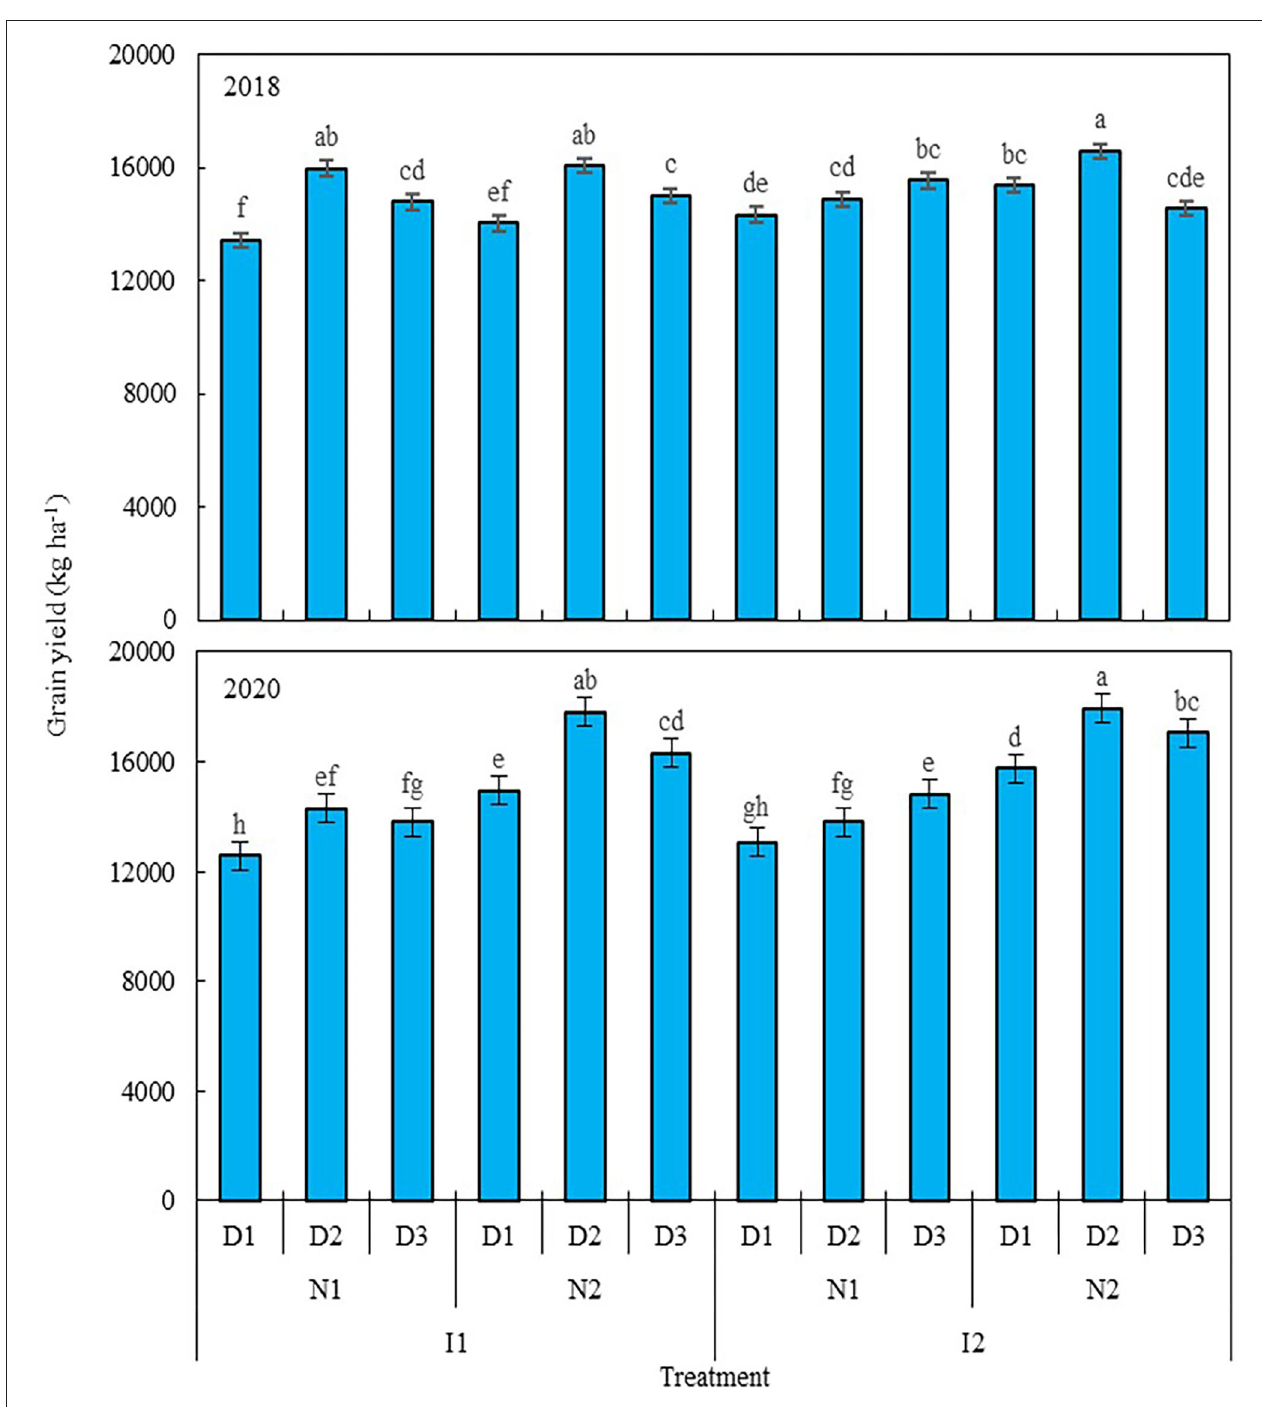
FIGURE 2 | Grain yield of maize as affected by the levels of water, nitrogen, and density in 2018 and 2020. Error bars are standard errors of the means. Different lowercase letters above bars indicate significant differences at the P < 0.05 probability level. Descriptions of the irrigation level, nitrogen level, and planting density abbreviations are shown in Table 1